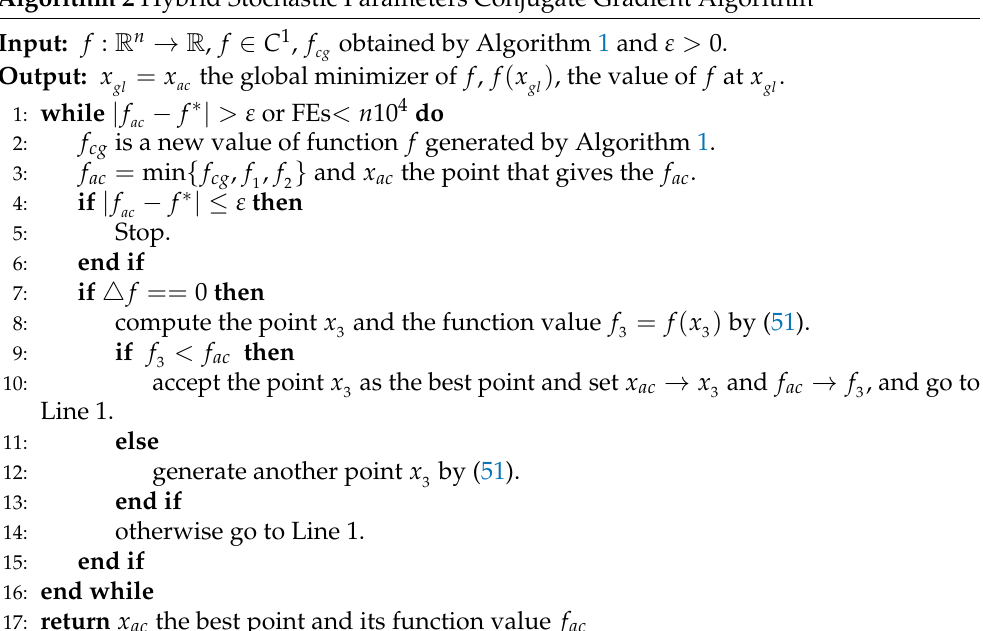
Algorithm 2 Hybrid Stochastic Parameters Conjugate Gradient Algorithm